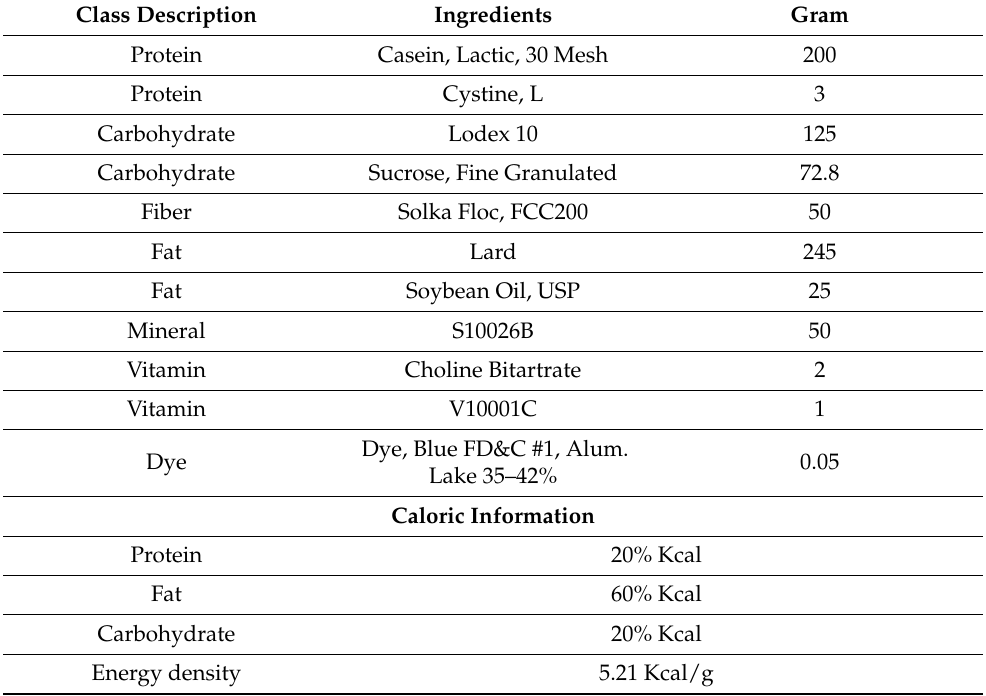
Table 1. Rodent Diet with 60% kcal Fat